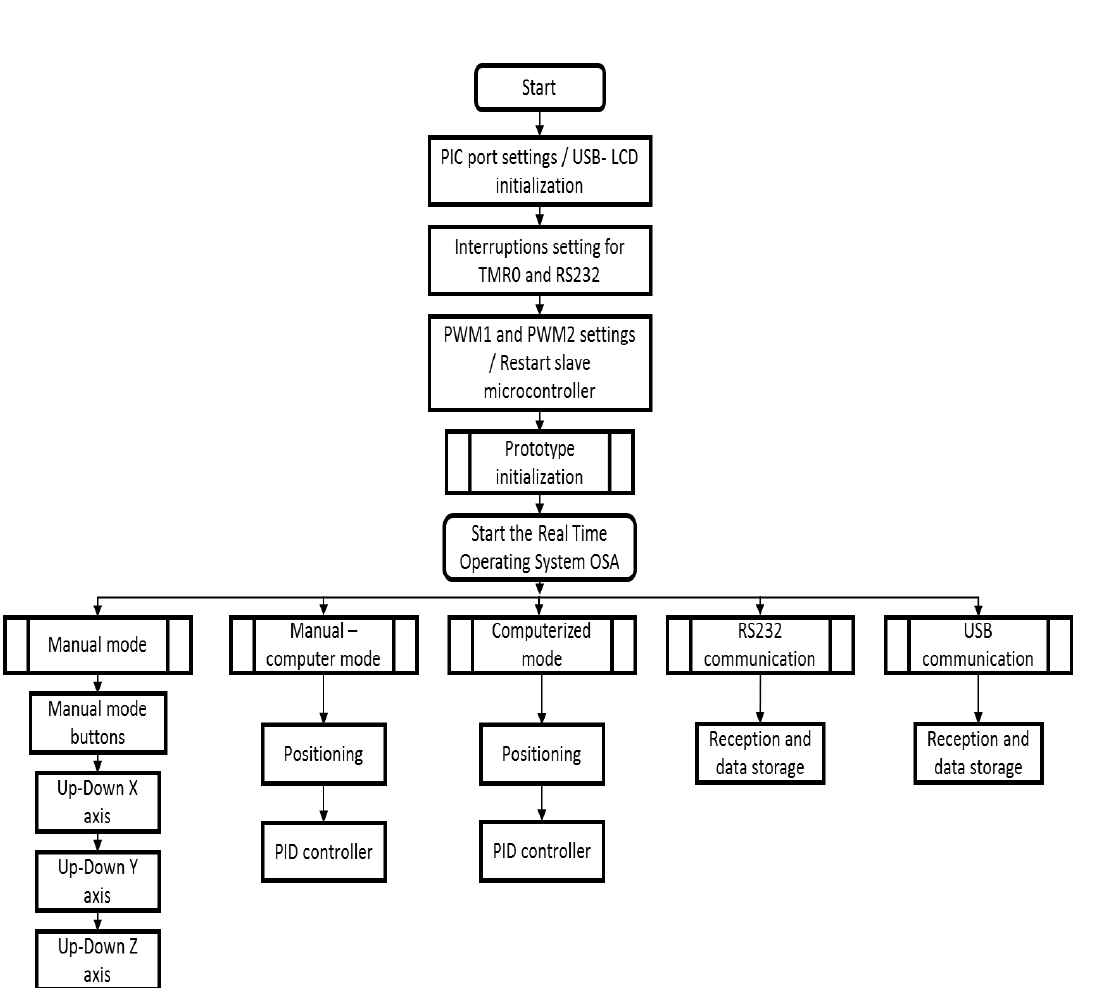
Figure 8. Flowchart of real time operating system OSA.